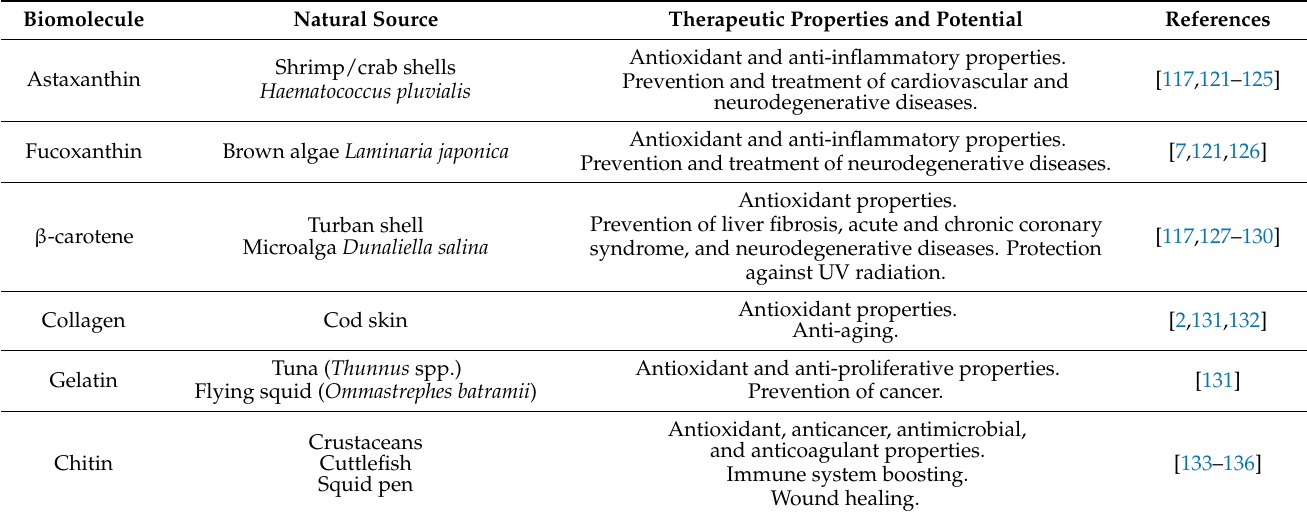
Table 1. Examples of antioxidant biomolecules from marine